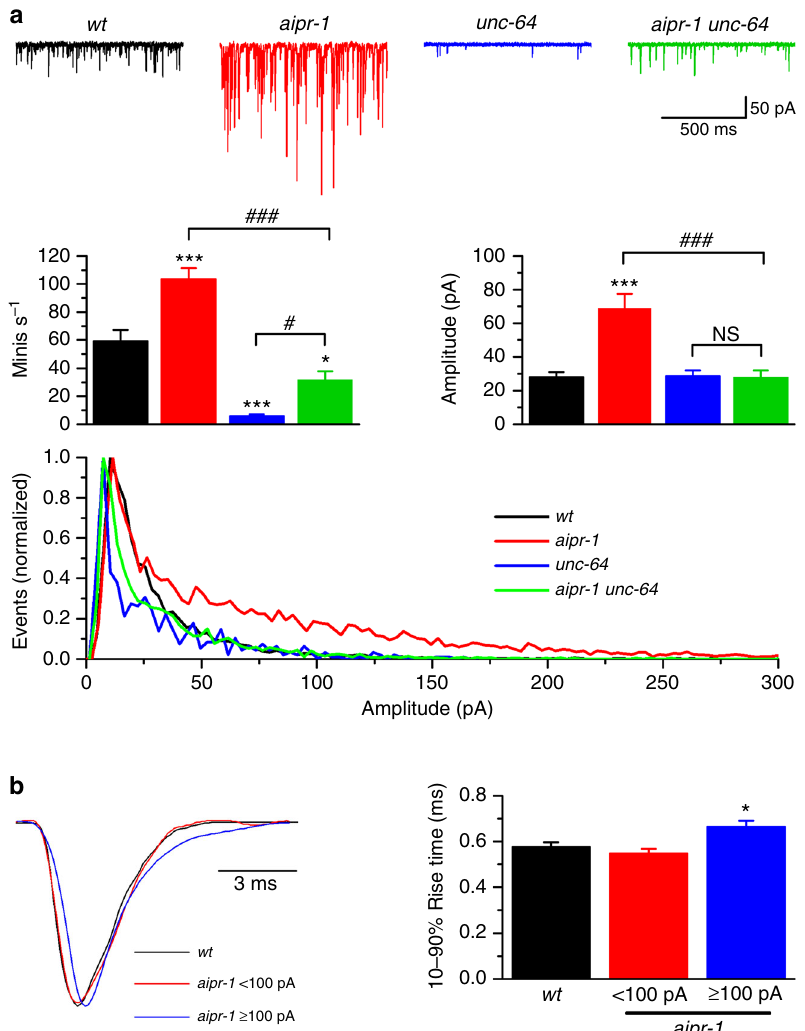
Fig. 6 AIPR-1 inhibits synchrony of spontaneous release. a Mutation of unc-64 (syntaxin) precluded the enhancing effect of aipr-1(zw86) on the amplitude of spontaneous miniature currents (minis). Frequency, mean amplitude, and amplitude distribution of minis are compared among the wild type ( wt ) ( n = 9), aipr-1(zw86) ( n = 7), unc-64(e246) ( n = 9), and aipr-1(zw86) unc-64(e246) ( n = 8). It is noteworthy that the aipr-1 mutation increased large-amplitude events in the amplitude distribution graph and this effect was eliminated by a mutation in unc-64 . b Comparison of 10 – 90% rise time of minis between wild type ( wt ) and aipr-1(zw86) . The sample minis were normalized in amplitude and superimposed at an identical time scale. Data are shown as mean ± SEM. * p < 0.05, *** p < 0.001 compared with wt ; # p < 0.05, ### p < 0.001, and NS ( p > 0.05) compared between indicated groups (one-way ANOVA followed